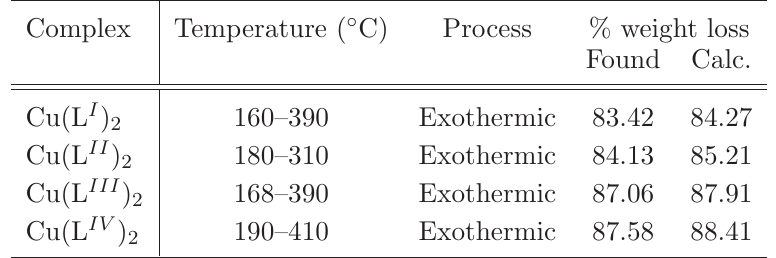
Table 1 TG/DTA data for decomposition of Cu (II)